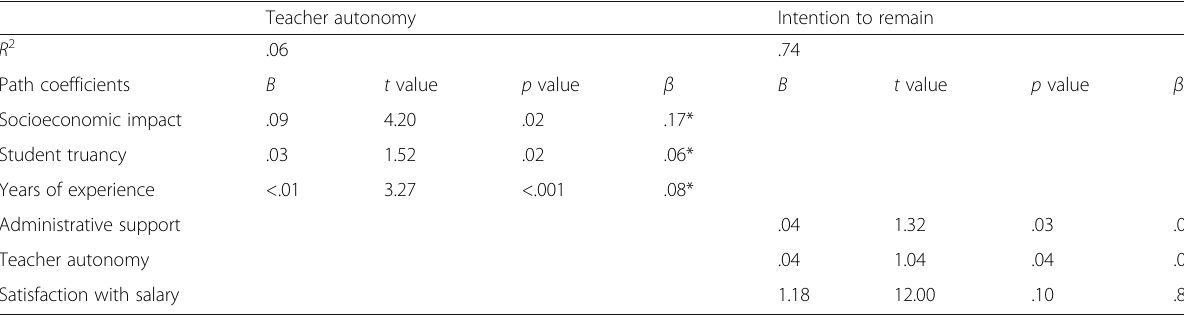
Table 5 Summary of the results of the tests of relative